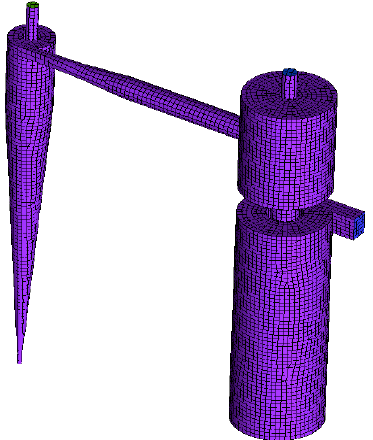
Figure 7. The meshing of four-products hydrocyclone.